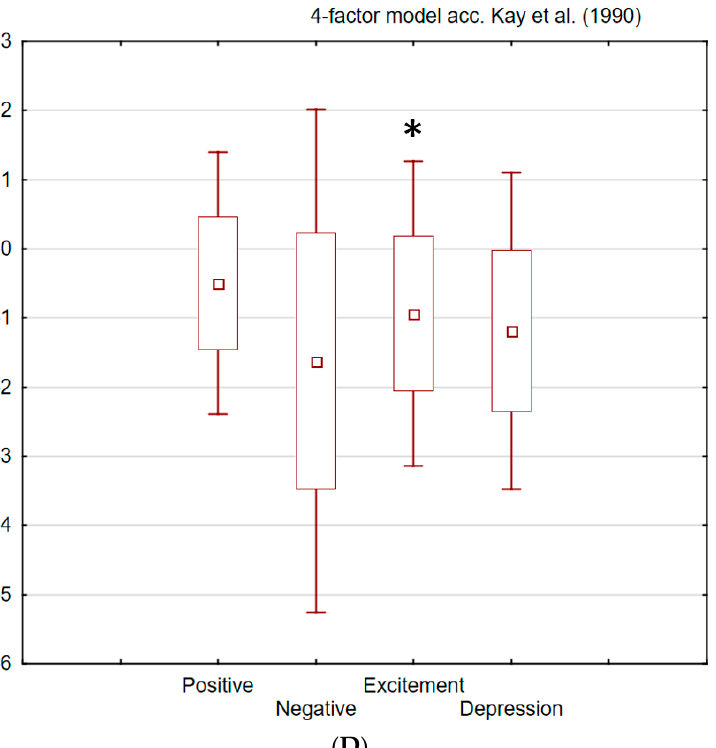
Figure 2. PANSS 3-month rehabilitation therapy results (mean differences for REH group over T1–T2 period) analyzed by four factor models. Factors significantly ( p < 0.05) and strongly (r > 0.5) correlated with NPS serum level marked with * for T1 and ** for T2. ( A ). Five-factor model according to Citrome et al. (2011) [40]. ( B ). Five-factor model according to Lim et al. (2021) [41]. ( C ). Four-factor model according to Walsh-Messinger et al. (2018) [35]. ( D ). Four-factor model according to Kay et al. (1990) [39].